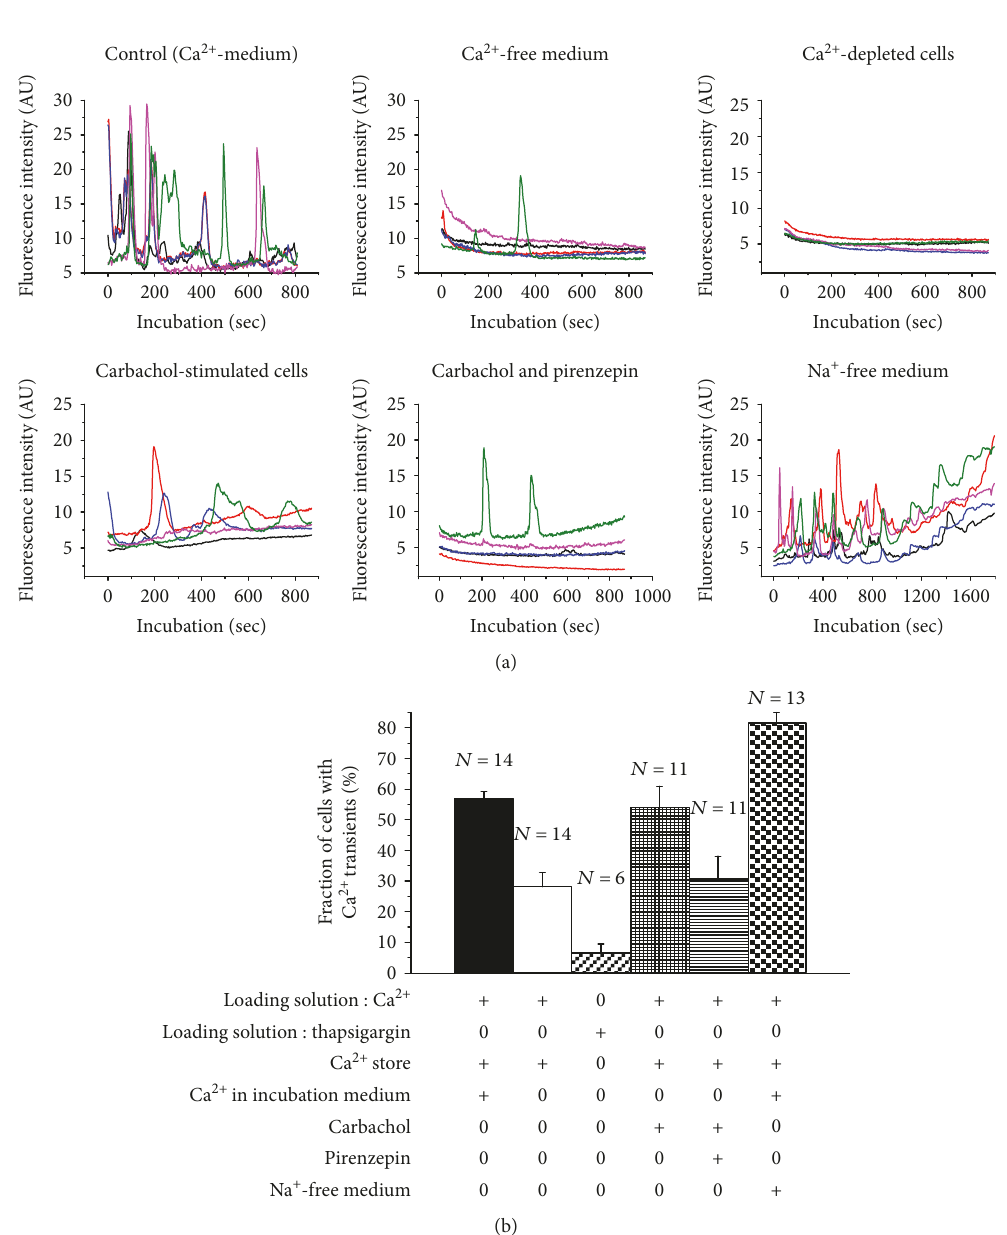
Figure 7: The fraction of proliferating cells with calcium transients during 15 min of incubation. Representative calcium traces from cells kept under six di ff erent experimental conditions (trace from fi ve cells in each group) (a). The cells were loaded with 5 μ M Fluo-4. Calcium was present during the loading and the incubation procedures as indicated on the fi gure. Thapsigargin was used for depletion of calcium stores. Thapsigargin was present during the loading procedure. Carbachol and pirenzepin were present during the incubation. Sodium- free solution was used only for the incubation. Mean values and SEM, 6 – 14 independent experiments